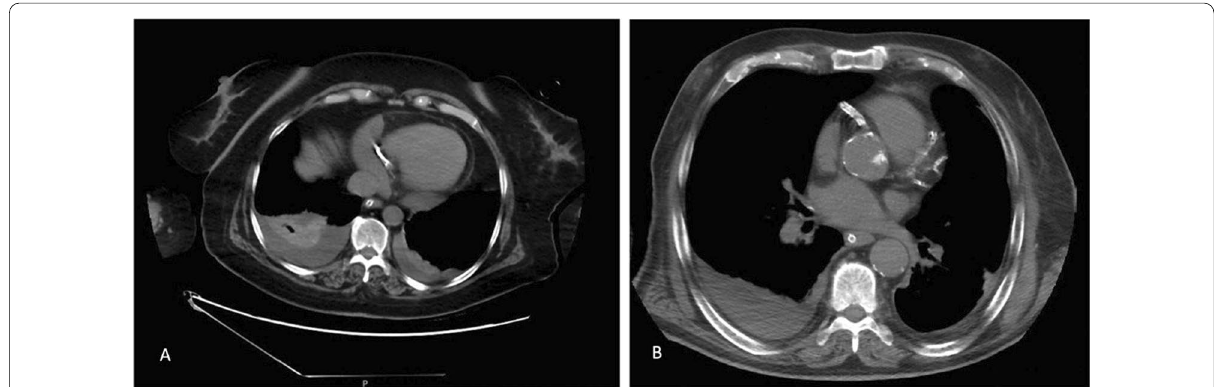
Fig. 2 Two different patients showing coronary arteries calcification. A A 59-year-old male with a history of heart attack, non-contrast CT image showing severe, dense coronary calcifications involving the RCA with mild bilateral plural effusion more in the right side with associated atelectatic changes. B A 63-year-old man presented with a history of HTN, smoking and previous stroke, non-contrast CT image showing moderate-to-severe, dense coronary calcifications in the aortic route and involving the left system (LCX and LAD) as well as RCA, mild right-sided plural effusion also